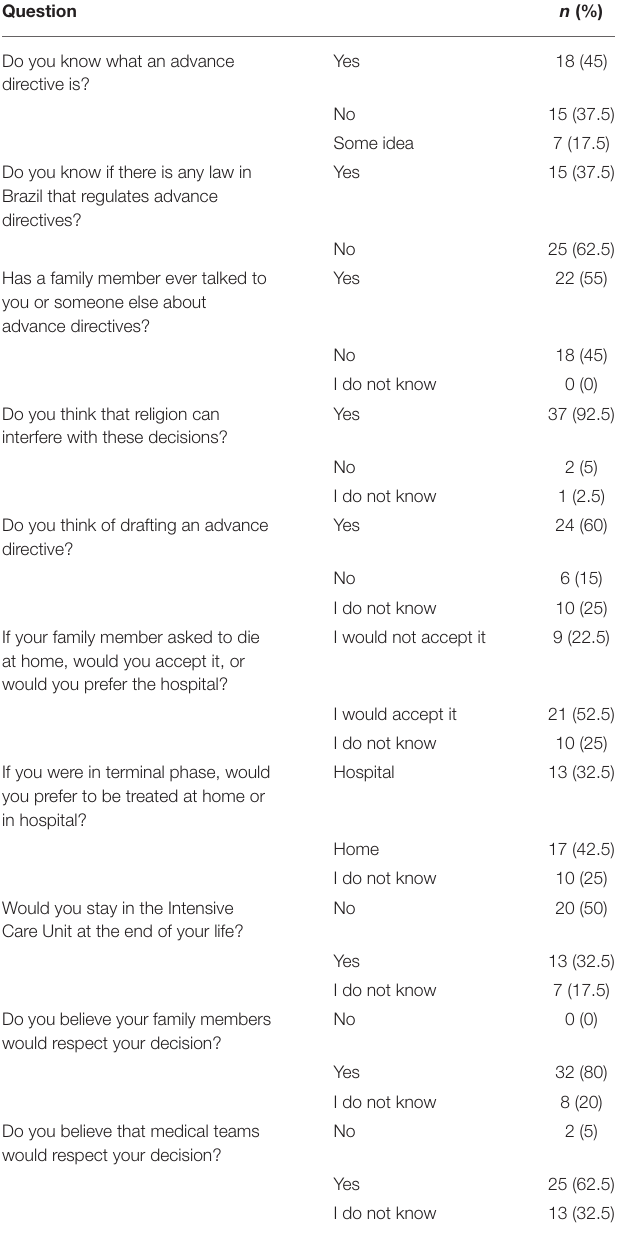
TABLE 2 | Responses of the 40 participants to the Advance Directives Questionnaire.